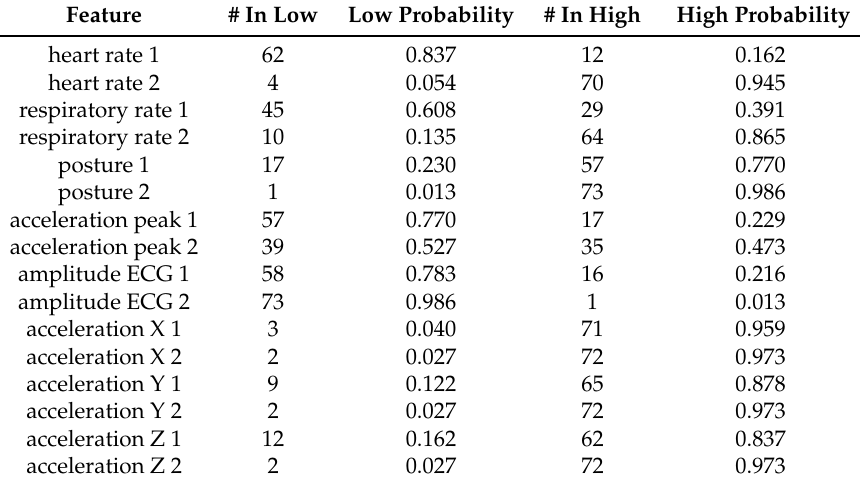
Table 4. Qualitative assignment.